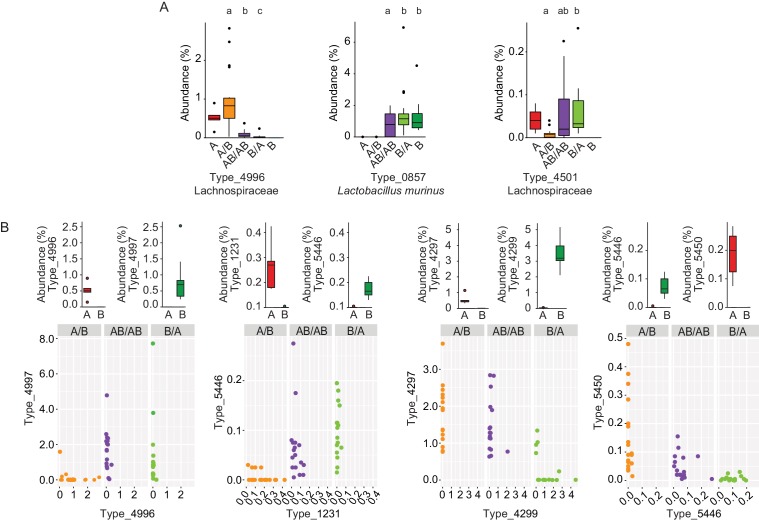
Bacterial types affected by colonization order and mechanisms of priority effects.(A) Examples of bacterial types with an advantage when inoculated first (Type_4996 and Type_0857), indicative of inhibitory priority effect, and when inoculated second (Type_4501), indicative of facilitation. Different letters indicate statistically significant differences between groups (values of donors A and B were not included in the statistical analysis but were plotted as a reference). (B) Associations between bacterial types affected by colonization order with phylogenetically related types in the competing community. Type_4996 and Type_4997 (7 mismatches in 16S rRNA gene tag, >97% identity), Types_4297 and Types_4999 (1 mismatch in 16S rRNA gene tag, >99% identity), Type_5446 and Type_1231 (4 mismatches in 16S rRNA gene tag, >98% identity), and Type_5450 and Type_5446 (2 mismatches in 16S rRNA gene tag, >99% identity) show negative correlations, indicative of niche pre-emption. Each experiment was done in duplicate, Donor A (n = 1), Donor B (n = 1), recipient mice A/B (n = 18), B/A (n = 16), AB/AB (n = 17). In panel (A) and top graphs in panel (B), boxplots are generated in ggplot in R. In panel (A) results from ANOVA statistical analysis are shown (experimental groups that share the same letters above are not significantly different, while those indicated with different letters are significantly different)(p<0.05).